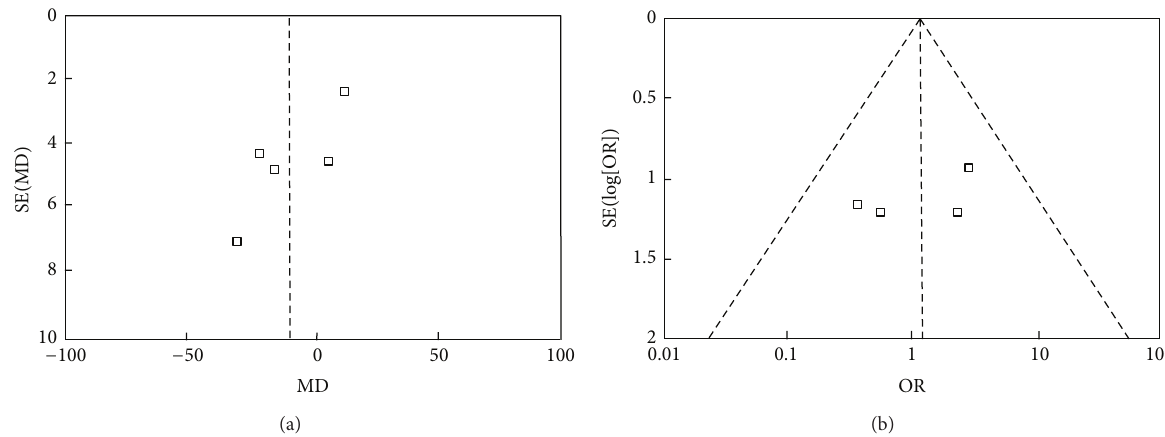
Figure 10: Funnel plot for operation time and the rate of reoperation demonstrating the evidence of publication bias. Basic symmetry of the above two funnel plot suggested that the possibility of publication bias is small ((a) operation time and (b) reoperation).